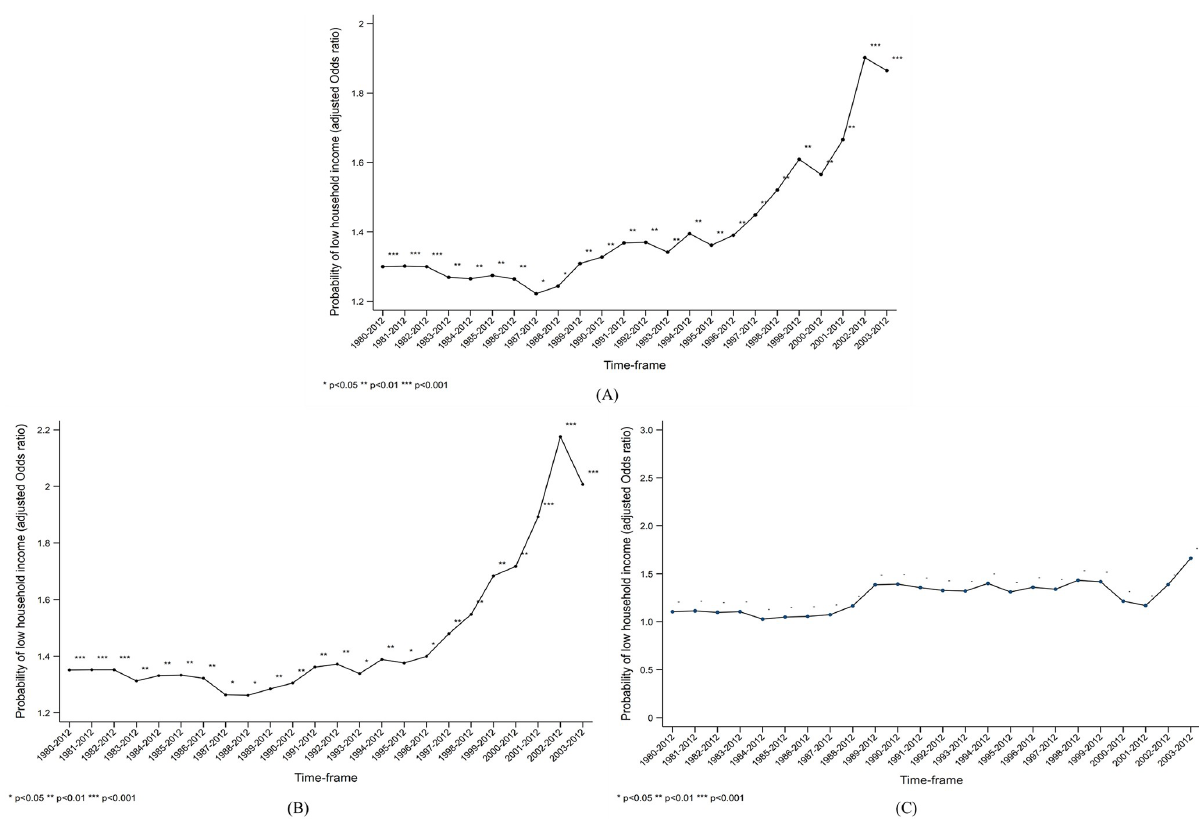
Fig 2. Probability of low household income between tuberculosis and non-tuberculosis group and its historical trend. (A) All study population included. (B) Comparison within low childhood socioeconomic position strata (C) Comparison within high childhood socioeconomic position strata.